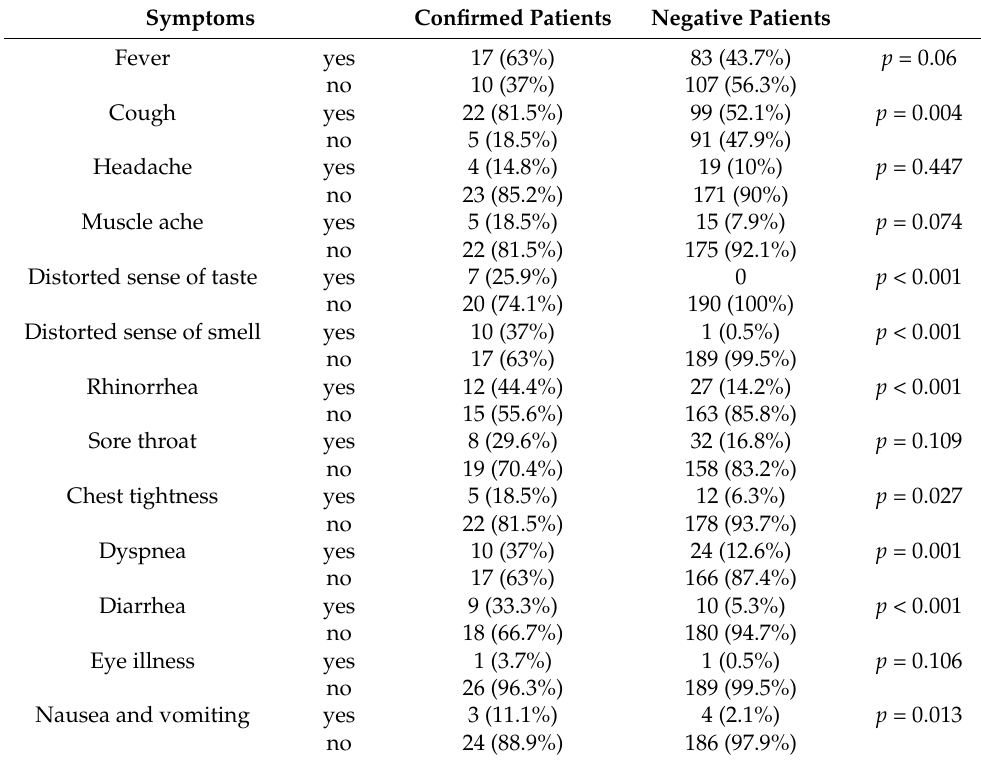
Table 2. Symptoms of confirmed COVID-19 patients and COVID-19-negative